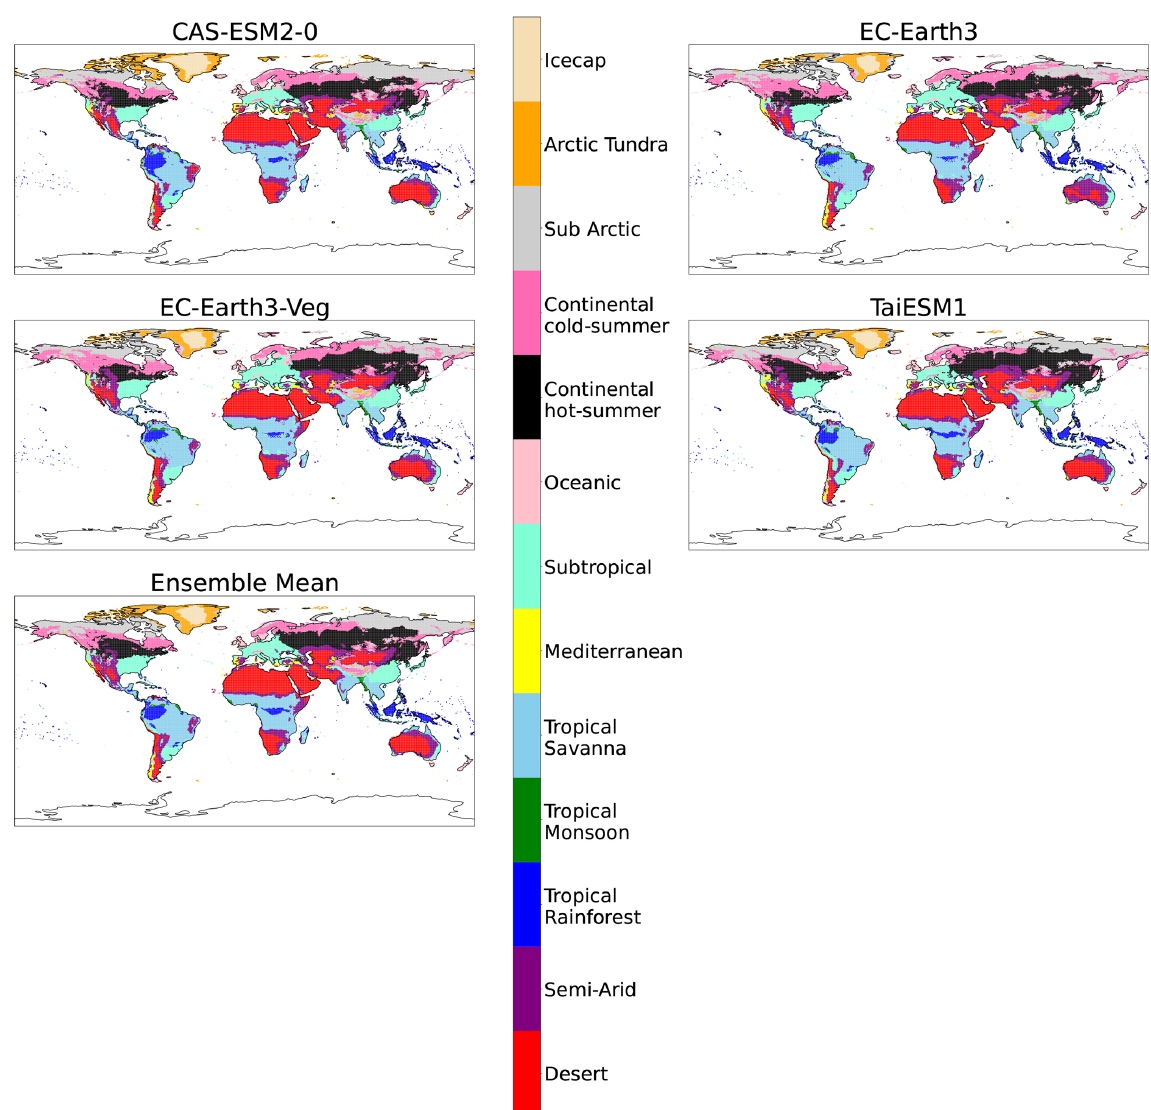
Figure B6. Maps of streamlined KG classifications for each model at + 4K with anomaly